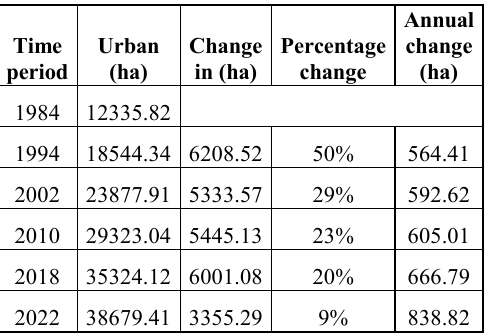
Table 4. Annual change of urban extension (1984-2022)